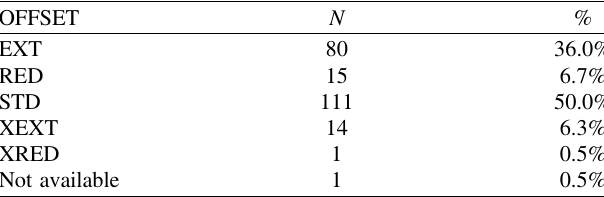
Table A.4. Kinectiv neck offset used.